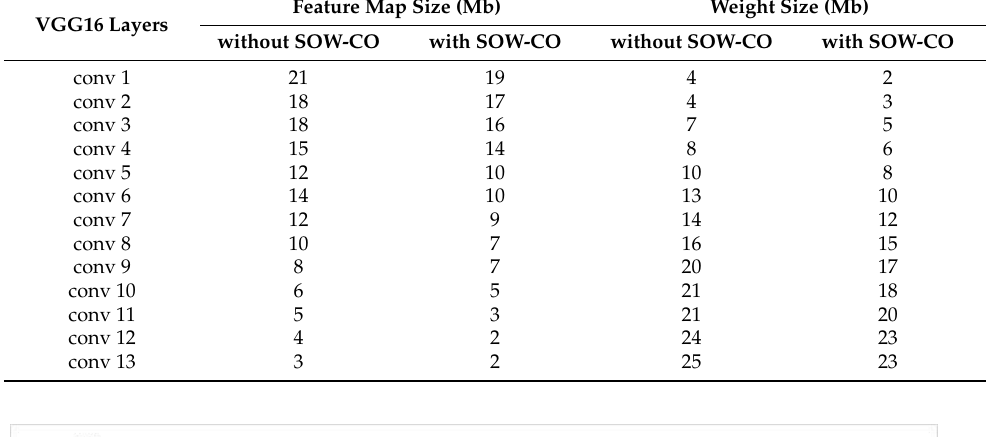
Table 3. Analysis of feature map and weight sizes for VGG16.